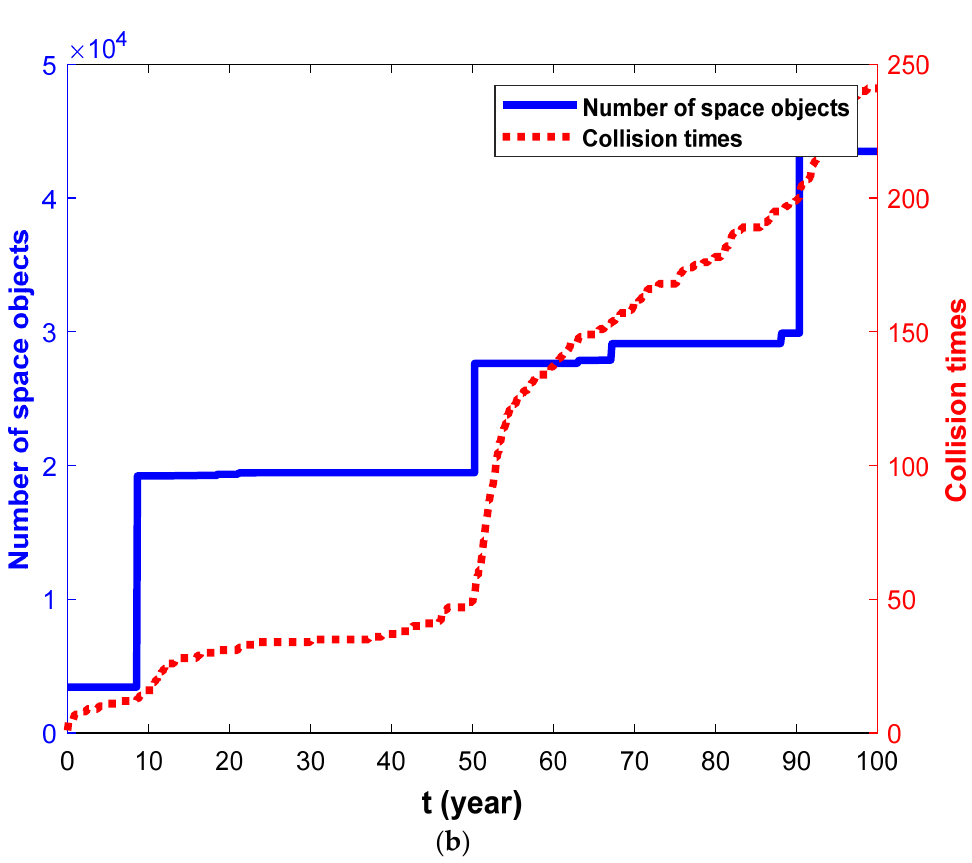
Figure 4. Two simulations of the second scenario: ( a ) simulation with the largest number of space objects after 100 years; ( b ) simulation with the smallest number of space objects after 100 years.